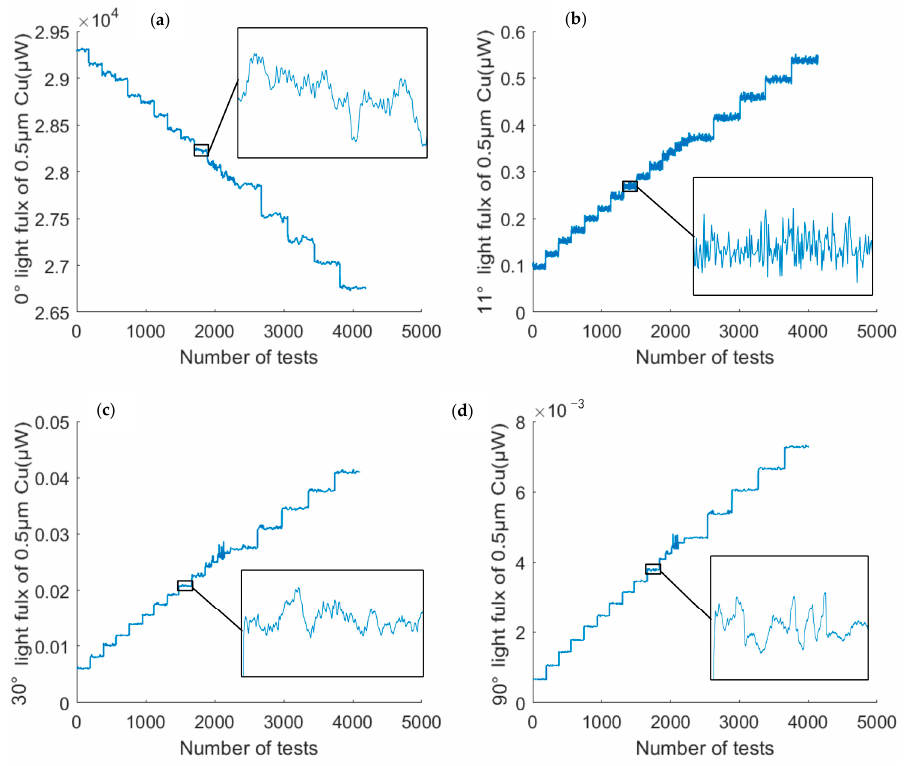
Sensors 2023 , 23 , x FOR PEER REVIEW Figure 13. Measured data of 0.5 μ m copper particles at ( a ) 0° ( b ) 11° ( c ) 30° and ( d ) 90°. Figure 13. Measured data of 0.5 µ m copper particles at ( a ) 0 ◦ ( b ) 11 ◦ ( c ) 30 ◦ and ( d ) 90 ◦ . After Pauta criterion screening for 200 data points in each group, the average value of each group’s data was calculated. The relationship between the light flux of every chan- nel and the particle mass concentration was drawn in Figure 14, and the linear fitting was carried out. As seen in Figure 14, the collected data at different mass concentrations had a good linearity, and the linearity of the fitting R 2 was better than 0.99.